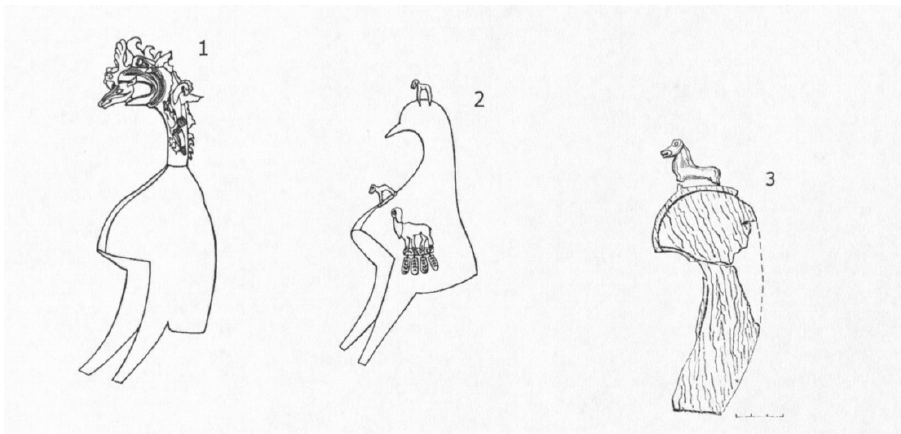
Figure 7. Reconstructed felt hats with wooden attachments: 1, Pazyryk K 2; 2, Verkh Kaldzhin-2, K3; 3. Wooden hat frame with attached animal Ulandryk II, K8 (adapted from Ochir-Goryaeva 2017: Figure 6).